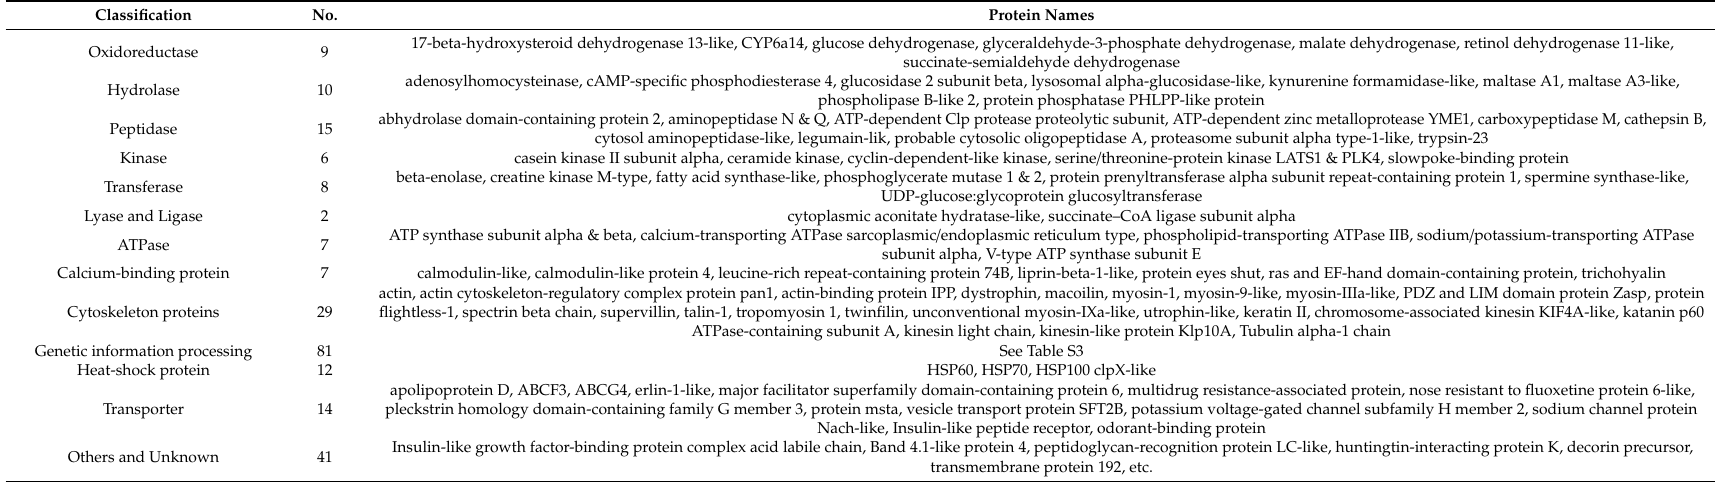
Table 2. Identified insect proteins from the green rice leafhopper (GRH) honeydew (matched peptides > 1).